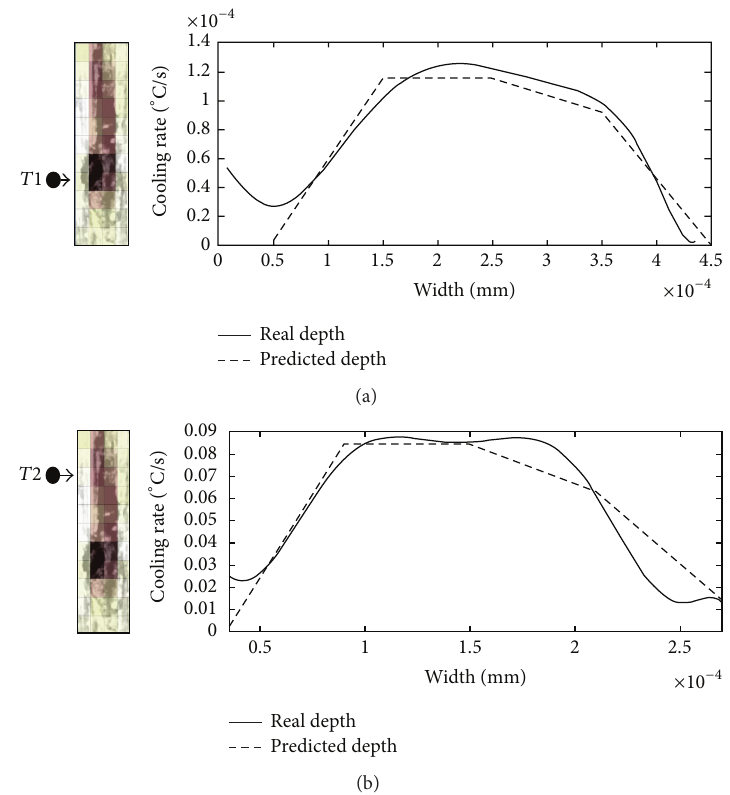
Figure 8: Transversal sections used for the internal validation of the model ( 𝑇1 (a) and 𝑇2 (b)).